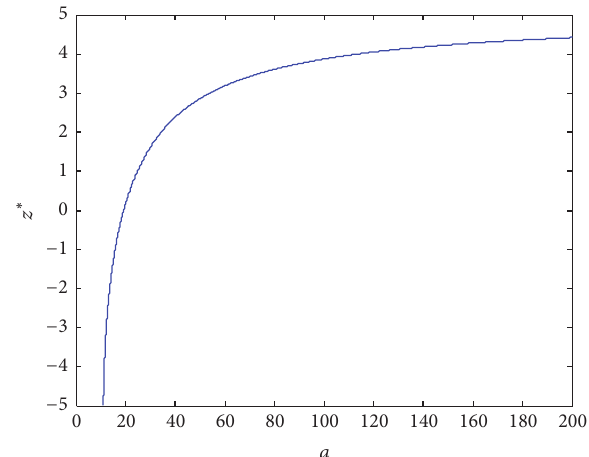
Figure 1: Stocking factor with market size varying (model M1).